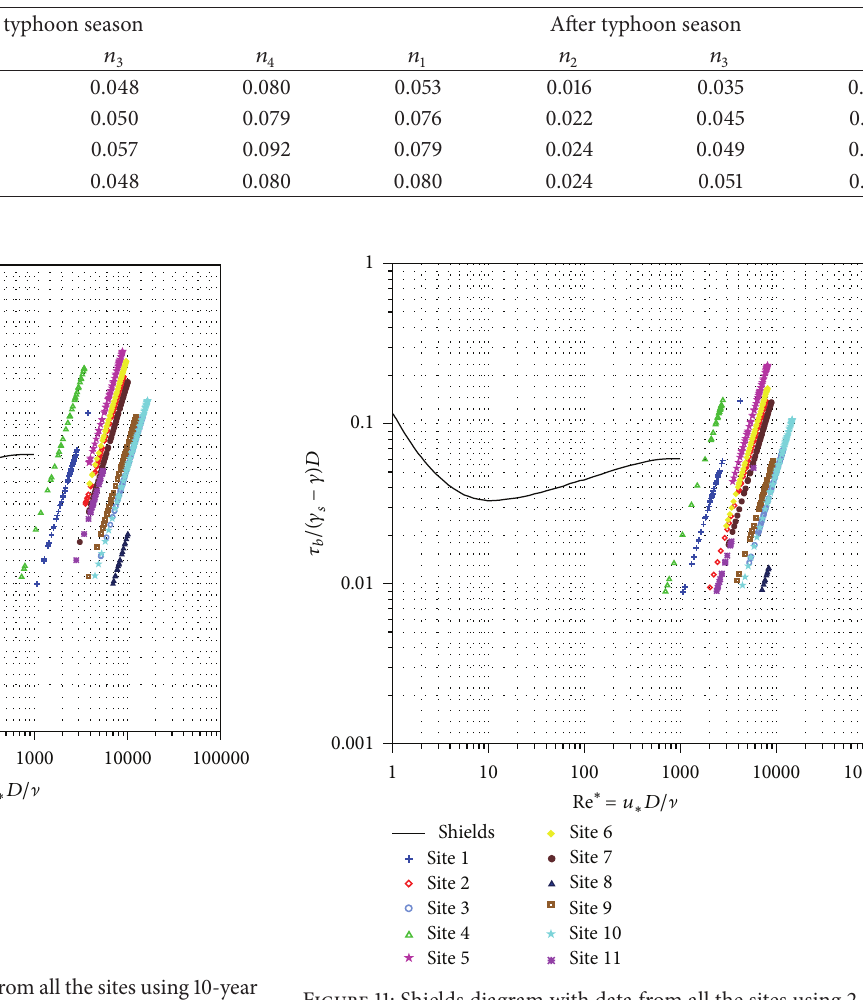
Figure 11: Shields diagram with data from all the sites using 2-year return period. (𝜏 𝑏 /(𝛾 𝑠 −𝛾)𝐷) , in which 𝜏 𝑏 is bed shear stress, 𝛾 𝑠 and 𝛾 are sediment and fluid densities, respectively, and 𝐷 is the grain size tobemovedmultipliedbyaccelerationduetogravity.Theparameter ( 𝑢 ∗ 𝐷/ ] ) represents the Reynolds number, in which 𝑢 ∗ is the shear velocity and ] is the kinematic